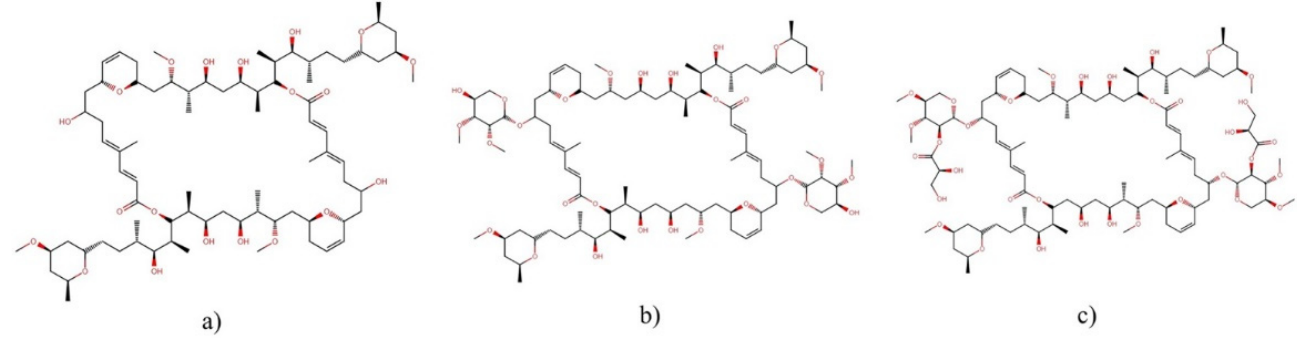
Figure 3. Chemical structures of ( a ) swinholide A, ( b ) ankaraholide A, and ( c ) samholide A.